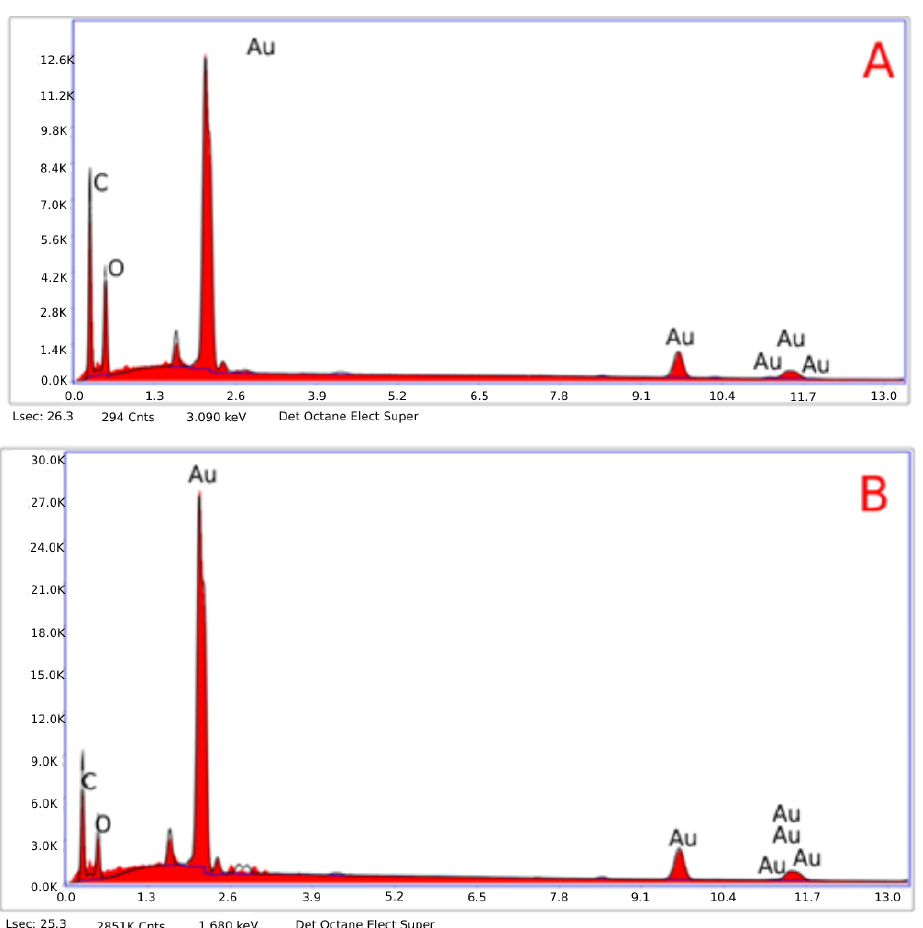
Figure 5. EDX spectrum shows a sharp peak at 2.3 keV confirming gold ’ s presence. ( A ) H-AuNFs and ( B ) R-AuNFs.